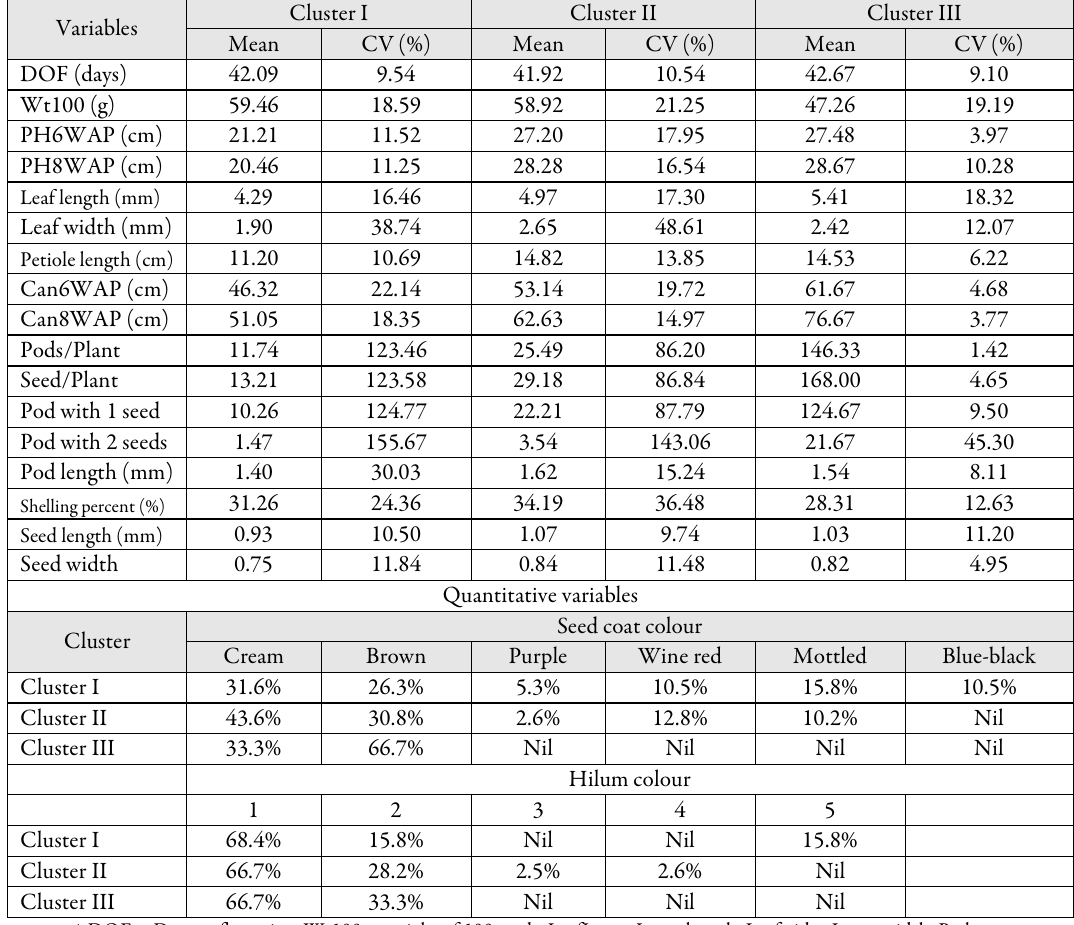
Table 4. Measures of average, variability and proportion of the quantitative and qualitative traits within each of the three clusters Cluster Variables